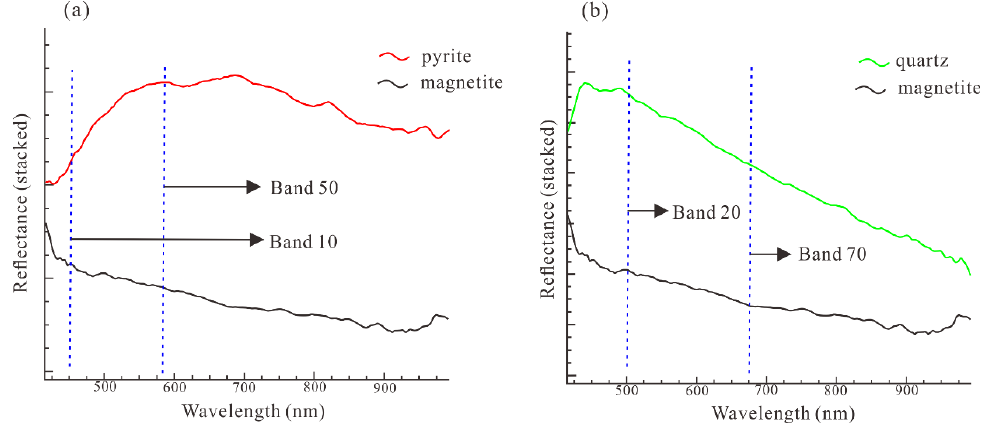
Figure 10. The visible and near-infrared spectral range (VNIR) spectra of magnetite, pyrite, and quartz: ( a ) spectra of pyrite and magnetite in Q-2 and ( b ) spectra of quartz and magnetite in Q-12.